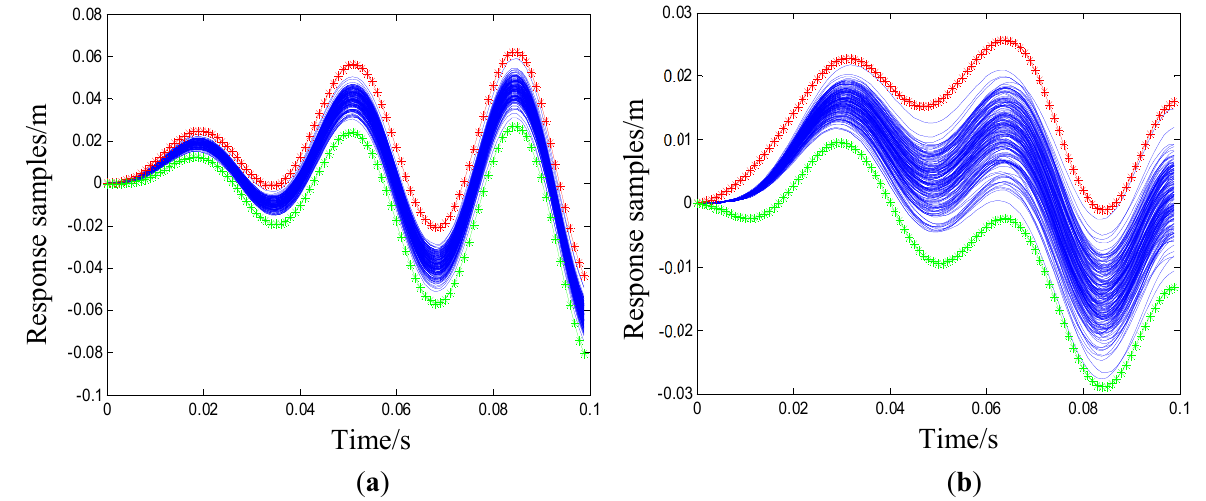
Figure 8. Samples and boundaries of the measured physical responses on Points 1 and 2. ( a ) Point 1. ( b ) Point 2.